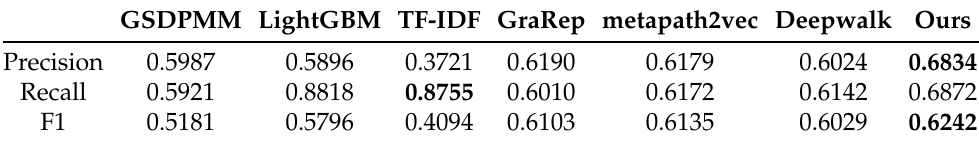
Table 7. Name disambiguation experimental results (%) (Bold: